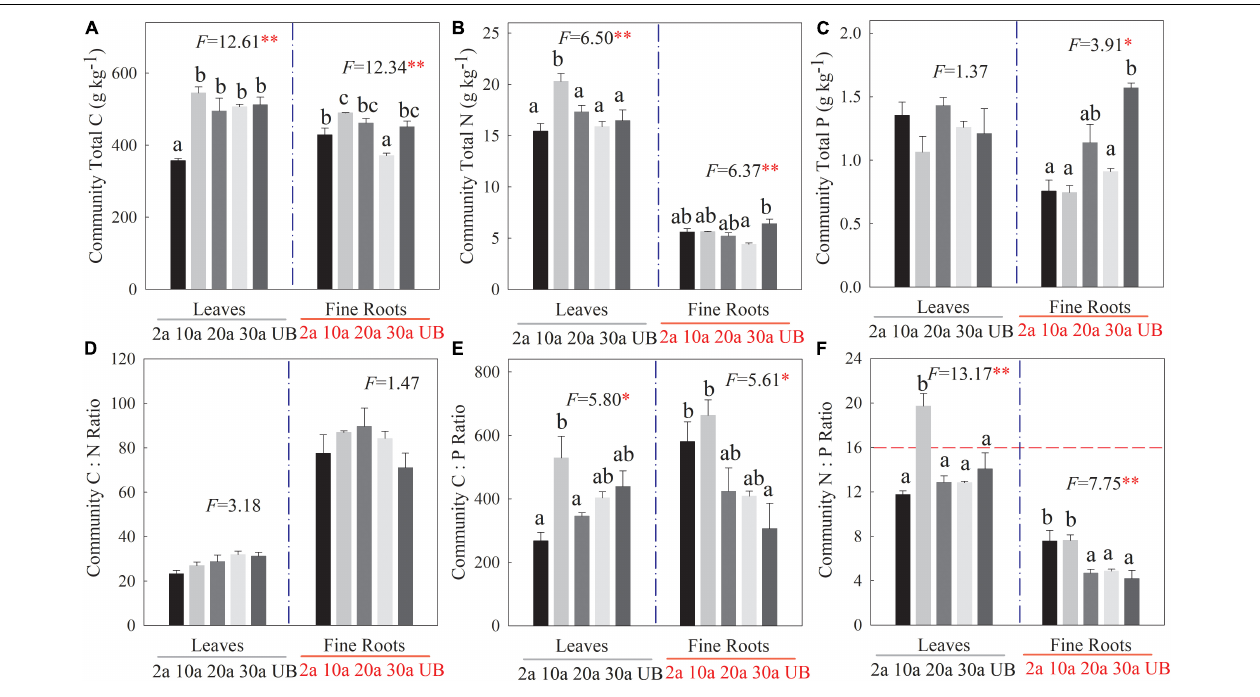
FIGURE 4 | Changes in C, N, and P stoichiometry of leaf and fine root at community level among different recovery periods. 2a, 10a, 20a, and 30a are at year 2, year 10, year 20, and year 30 after recovery, respectively. UB, unburned. Error bars are standard errors. Different lowercase letters indicate significant differences among different recovery periods. The dashed horizontal line stands for N:P ratio = 16 above which indicates the P limitation in subfigure (f). The number of the data involved in ANOVA in each recovery period was as follows: 2a: n = 9, 10a: n = 9, 20a: n = 9, 30a: n = 9, UB: n = 9 (** P < 0.01; * P < 0.05). (A–C) The stoichiometry concentration. (D–F) The stoichiometry